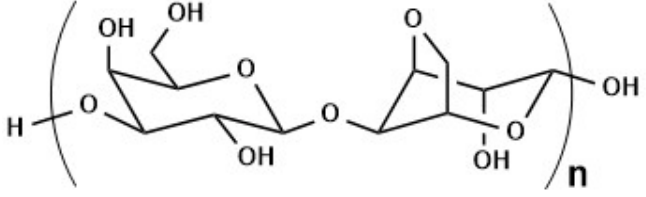
Figure 20. The structure of